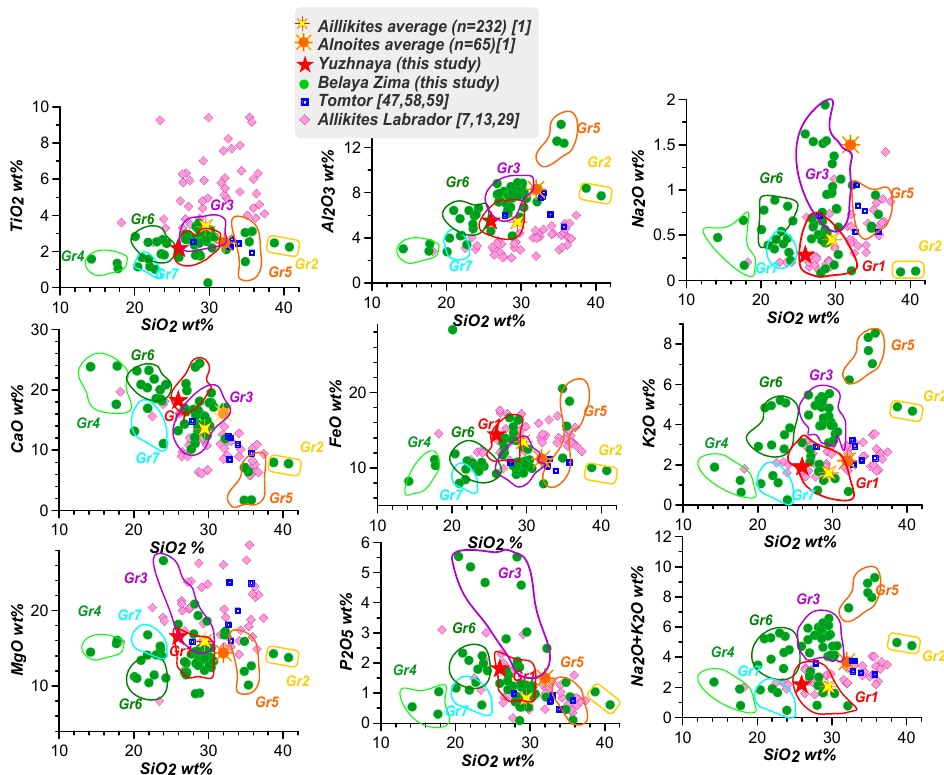
Figure 9. Variations of bulk rock compositions of BZM aillikites in comparison with the Labrador aillikites [7,13,29,57] and Tomtor lamprophyres [6,47,58,59].